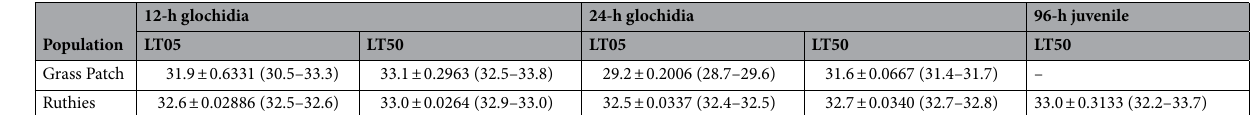
12-h glochidia Population Grass Patch Table 1. Laboratory derived lethal temperatures for 5% (LT05) and 50% (LT50) of Popenaias popeii glochidia and juveniles from two Devils River populations at 12, 24, and 96-h timepoints. Mean ± SE (95% CI), N = 3.